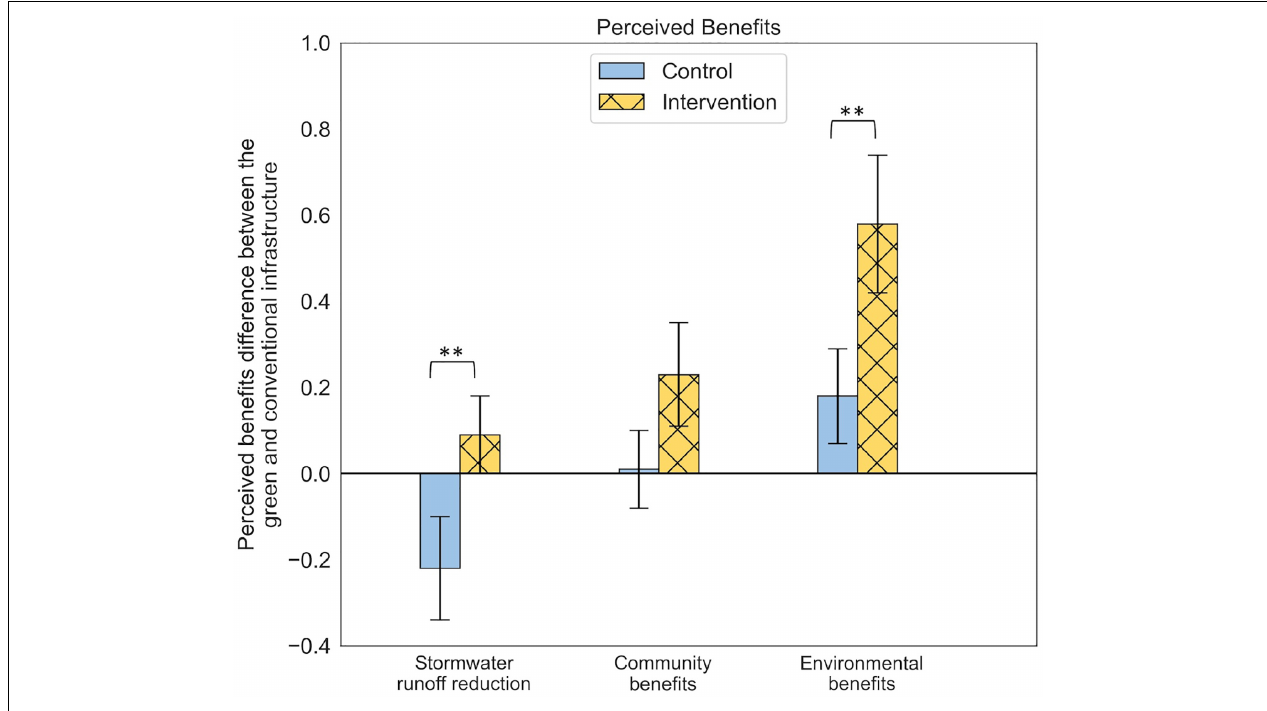
FIGURE 3 | Perceived benefits difference between the green and conventional infrastructure. ∗∗ p < 0.05.